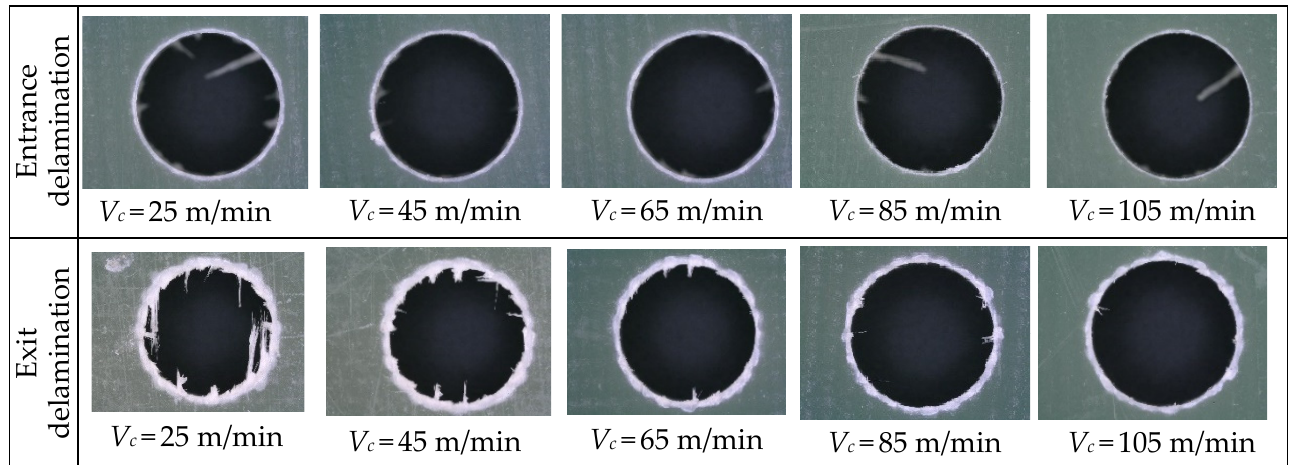
Figure 4. Morphology of entrance and exit at different cutting speeds ( f = 10 mm/min, drill bit diameter = 6 mm).